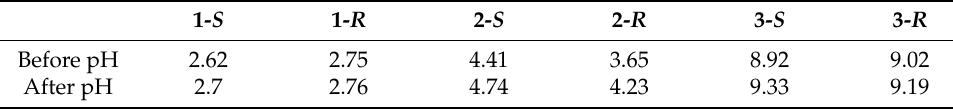
Table 2. The 1- S / R to 3-S/ R pH before and after